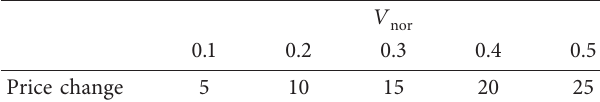
Table 7: Magnitude of change from previous market price when rebalancing order quantity is equal to order quantity threshold.